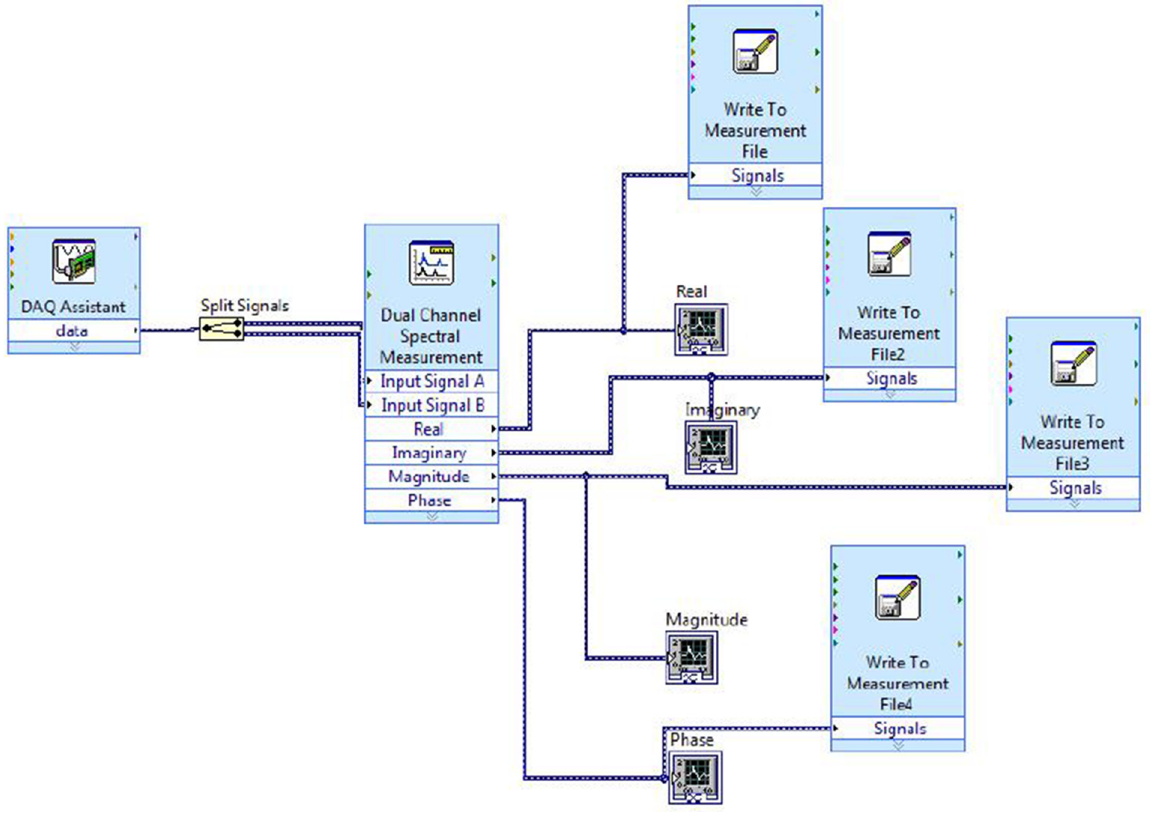
Fig. 9. Circuit diagram in LABVIEW.